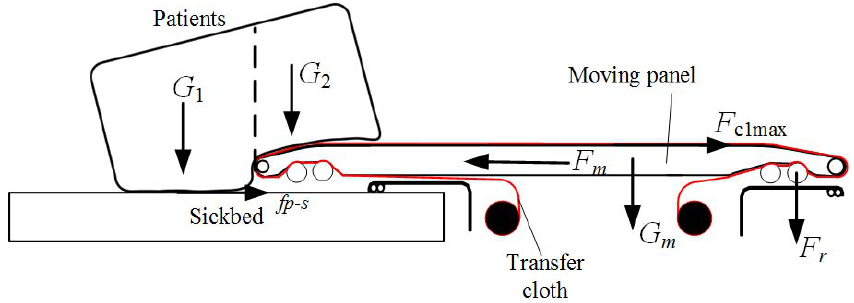
Figure 9. Driving force analysis of the moving panel.